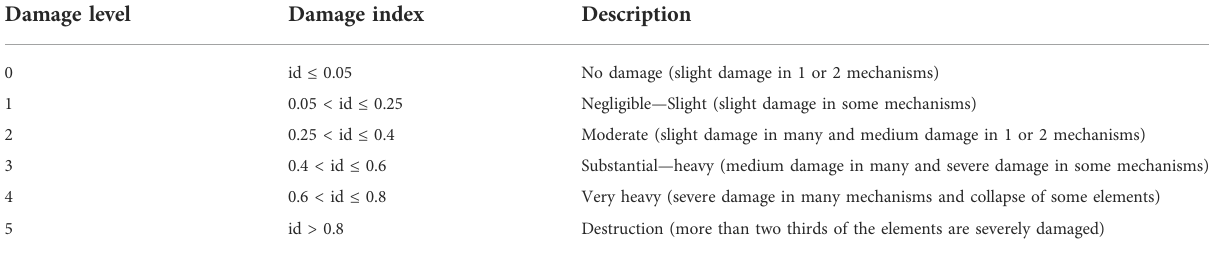
TABLE 6 Correlation between damage level ( D k ) and damage index ( i d ) Lagomarsino and Podestà (2004). Damage